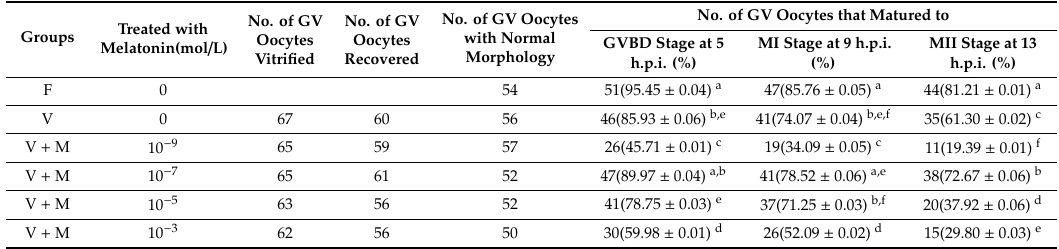
Table 2. In vitro maturation of vitrified mouse GV oocytes after melatonin treatment. No. of GV Oocytes that Matured to No. of GV Oocytes No. of GV No. of GV Groups Treated with with Normal Oocytes Oocytes GVBD Stage at 5 MI Stage at 9 h.p.i. MII Stage at 13 Melatonin(mol / L) Morphology Vitrified Recovered h.p.i. (%) (%) h.p.i.